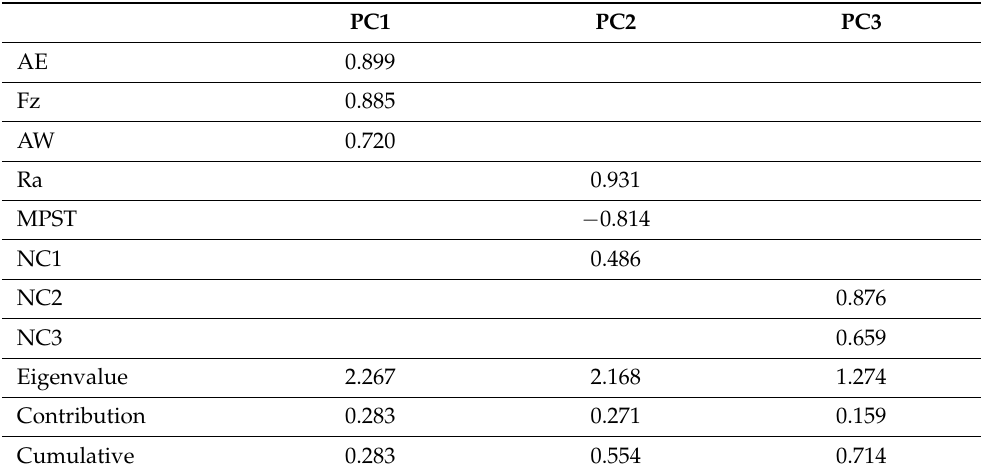
Figure 5. Scree plot of the eigenvalues. Table 6. Eigenvectors, eigenvalues, and explained variation (contribution) for the first three PCs after cluster rotation .